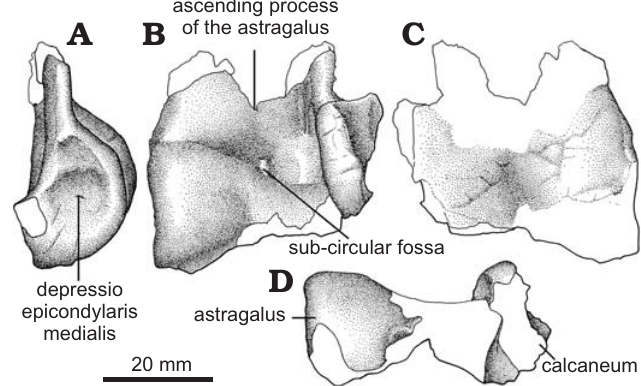
Fig. 6. Unenlagiid theropod Neuquenraptor argentinus Novas and Pol, 2005 (MCF PVPH 77) from Sierra del Portezuelo, Neuquén Province, Argentina; Portezuelo Formation, Coniacian, Late Cretaceous; partial left astragalocal- caneum in lateral ( A ), cranial ( B ), caudal ( C ), and distal ( D )